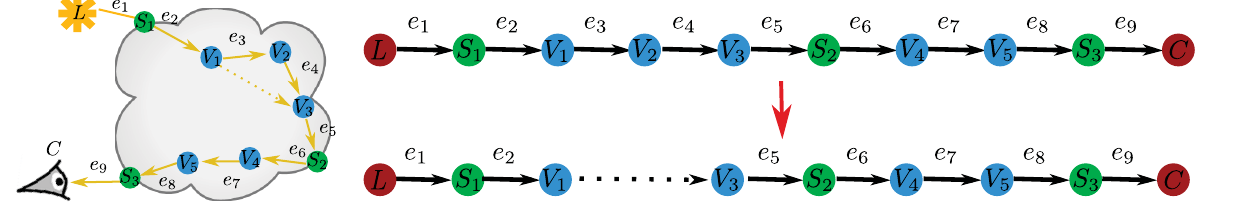
Fig. 13 The original path is replaced with a special path. Reproduced with permission from Ref. [23], c (cid:2) IEEE